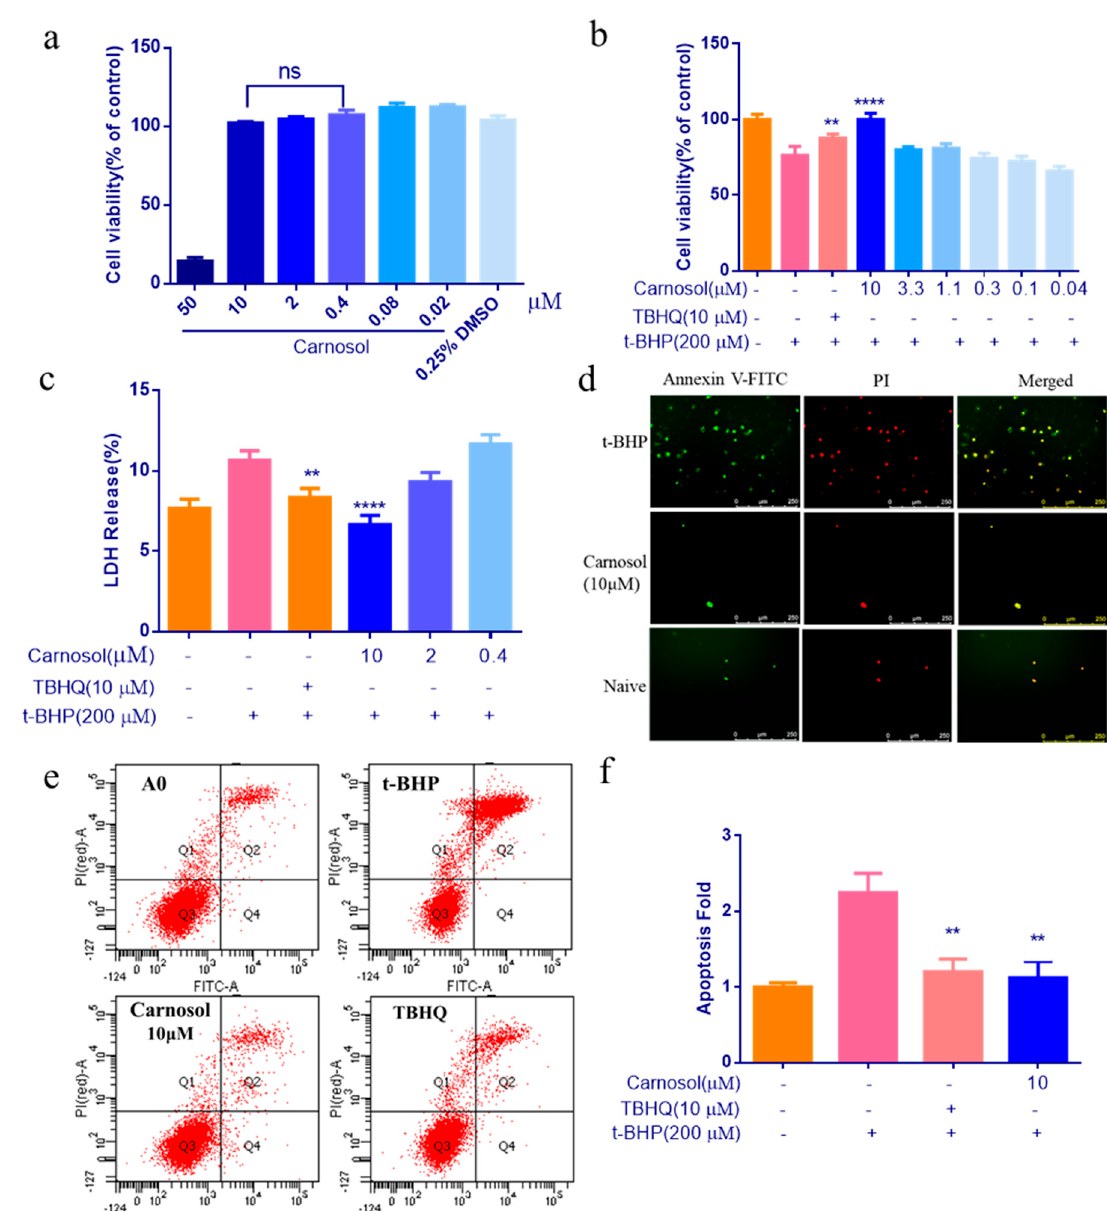
Figure 3. To evaluate the protective effect of carnosol in t-BHP-induced endothelial injury model. ( a ) Evaluating the cell viability of carnosol by CCK-8 assay. ( b ) The cell viability of carnosol pretreated cells after t-BHP-treated for 3 h. ( c ) The levels of the release of LDH were measured using LDH kits. ( d ) the green fluorescence is Annexin V-FITC staining positive cell, and the red fluorescence is propidium iodide (PI) staining positive cell at lower magnification (10×). Apoptotic cells were stained only by green fluorescence, necrotic cells were stained with green and red fluorescence, and normal cells were not stained with fluorescence. ( e – f ) Detection of apoptosis by flow cytometry. Apoptotic cells were distributed in Q2 and Q4 regions. ** p < 0.01, **** p < 0.0001, ns: no significant difference. 200 μ M t-BHP-treated as model group, TBHQ (10 μ M) was used as a positive control group, 0.25% DMSO-treated as negative control group, compared with model group. Results are expressed as mean ± SD ( n = 3).